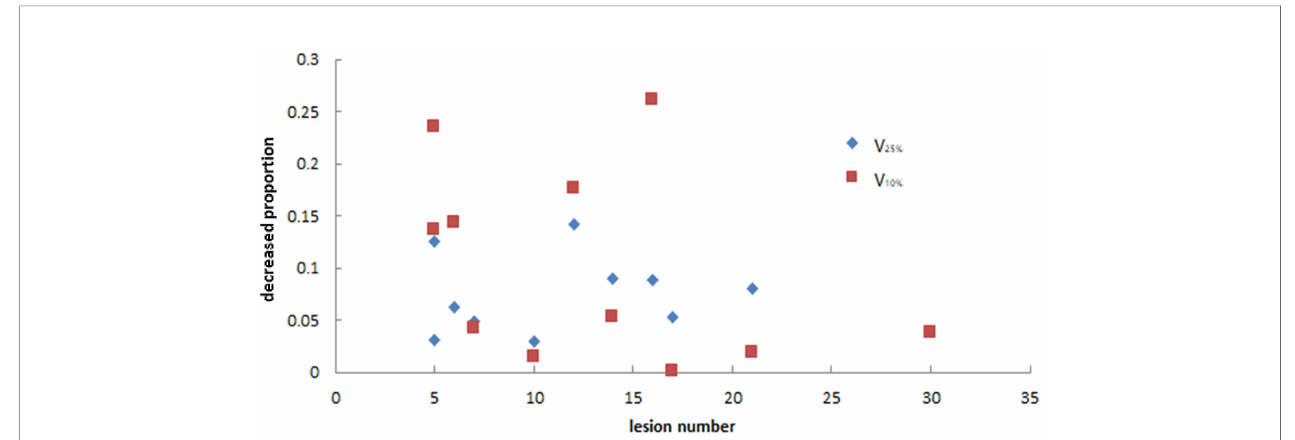
FIGURE 7 | The relationship between the decreased proportion of V 25% and V 10% of normal brain in LGS plans and the number of lesions. There was no obvious correlation between the two factors.